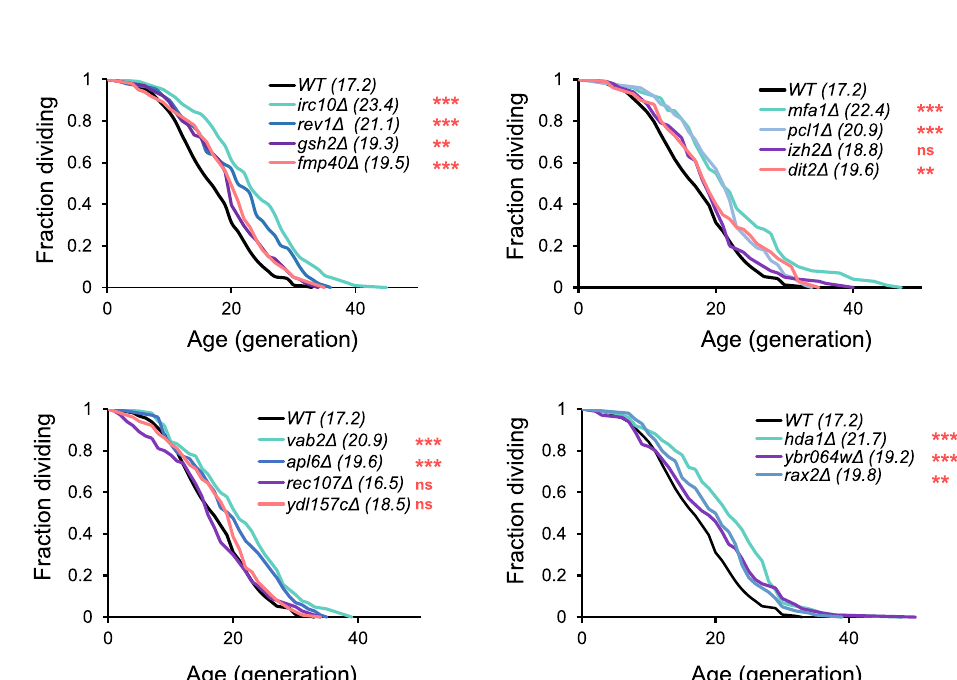
Fig. 3 Gene interaction network analysis and micro fl uidic validation of SEBYL results. A Functional clustering of 285 long-lived deletion mutants. Circles represent long-lived deletions; edges are published physical protein – protein interactions. Overrepresented categories are highlighted in designated colors. B RLS of designated strains of both a and alpha mating types combined. Average RLS is noted in parenthesis. p -value calculated by two-sided Mann – Whitney U test. ns not signi fi cant, ** p < 0.01, *** p < 0.001. See Supplementary Data 3 for all statistical analysis on RLS experiments. See also Fig.